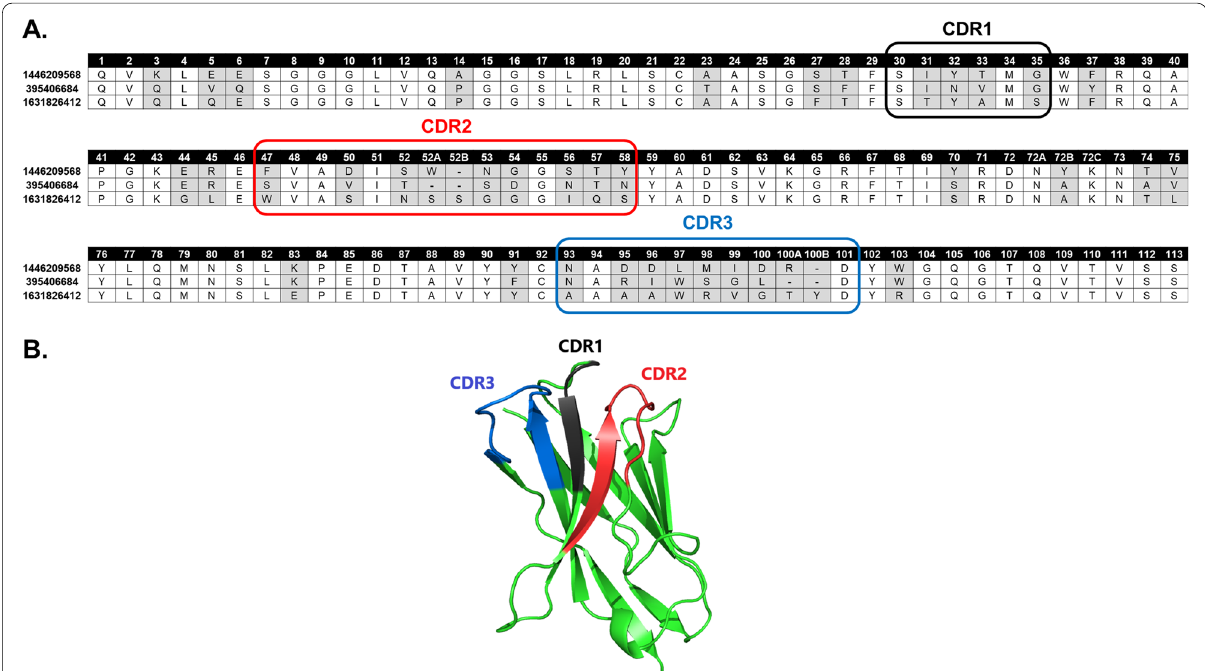
Fig. 1 CDRs of Nbs. A Representative Nb sequences with CDR1, CDR2, and CDR3 separated by conserved frameworks; residue positions were numbered by the widely used Martin scheme [1]. The Martin numbering scheme can accurately define the position of residues in the Nb sequences, which can then be used to locate the CDR automatically and conveniently. Positions with different residue alignment were colored in grey. These Nbs interacted with internalin B (gi: 1446209568, pdb: 6DBE), KRT19 (gi: 395406684), and melanoma-associated antigen B1 (gi: 1631826412, pdb: 6R7T), respectively. B CDR1, CDR2, and CDR3 loops in a crystallized